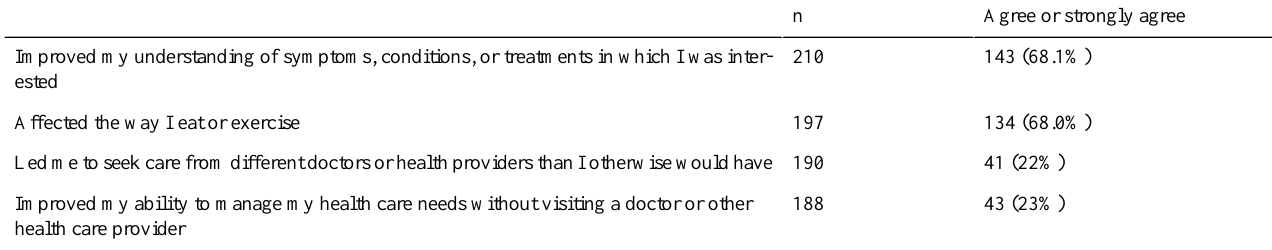
Agree or strongly agreen